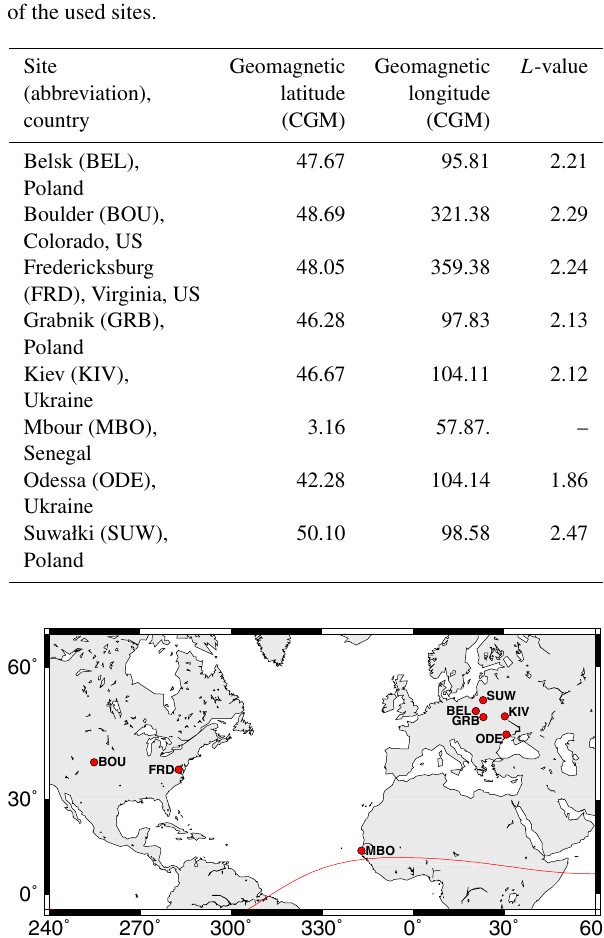
Table 2. Locations, geomagnetic coordinates (CGM), and L -values of the used sites.